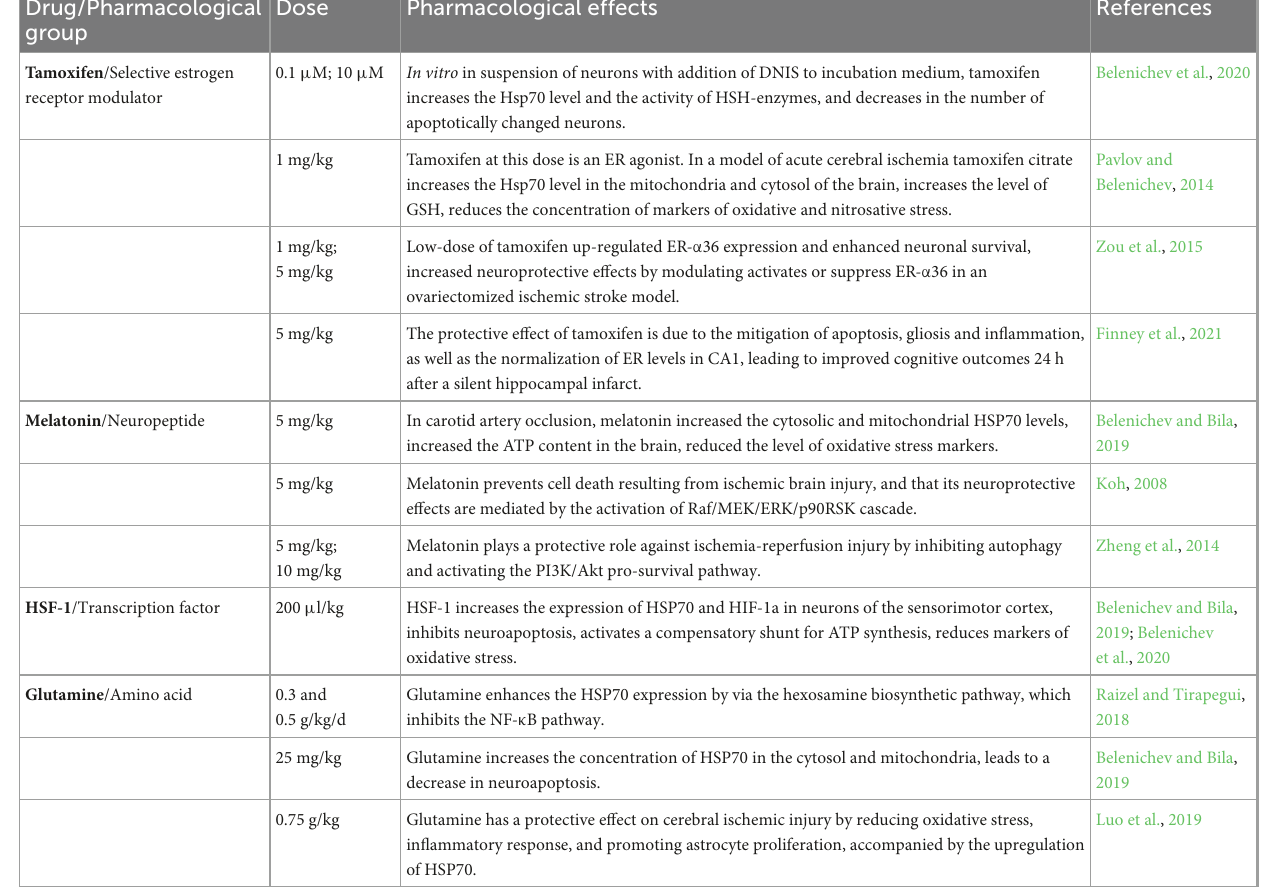
TABLE 1 Pharmacological characteristics of tamoxifen, melatonin, HSF-1, and